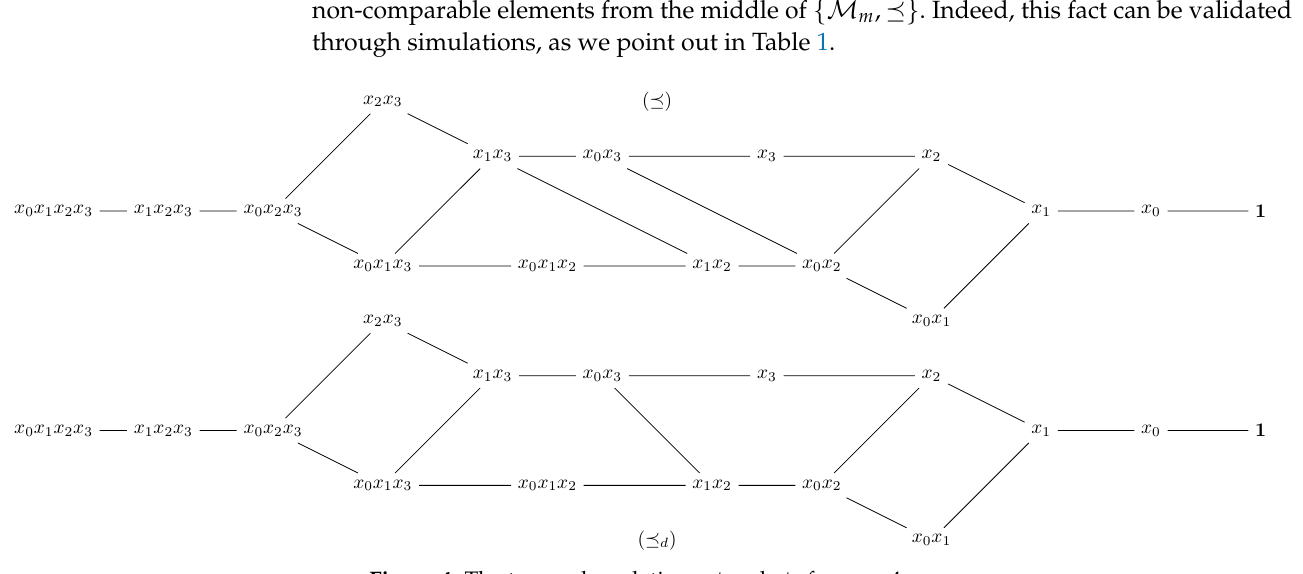
and for m = 4. (cid:22) (cid:22) d , {M m (cid:22)}